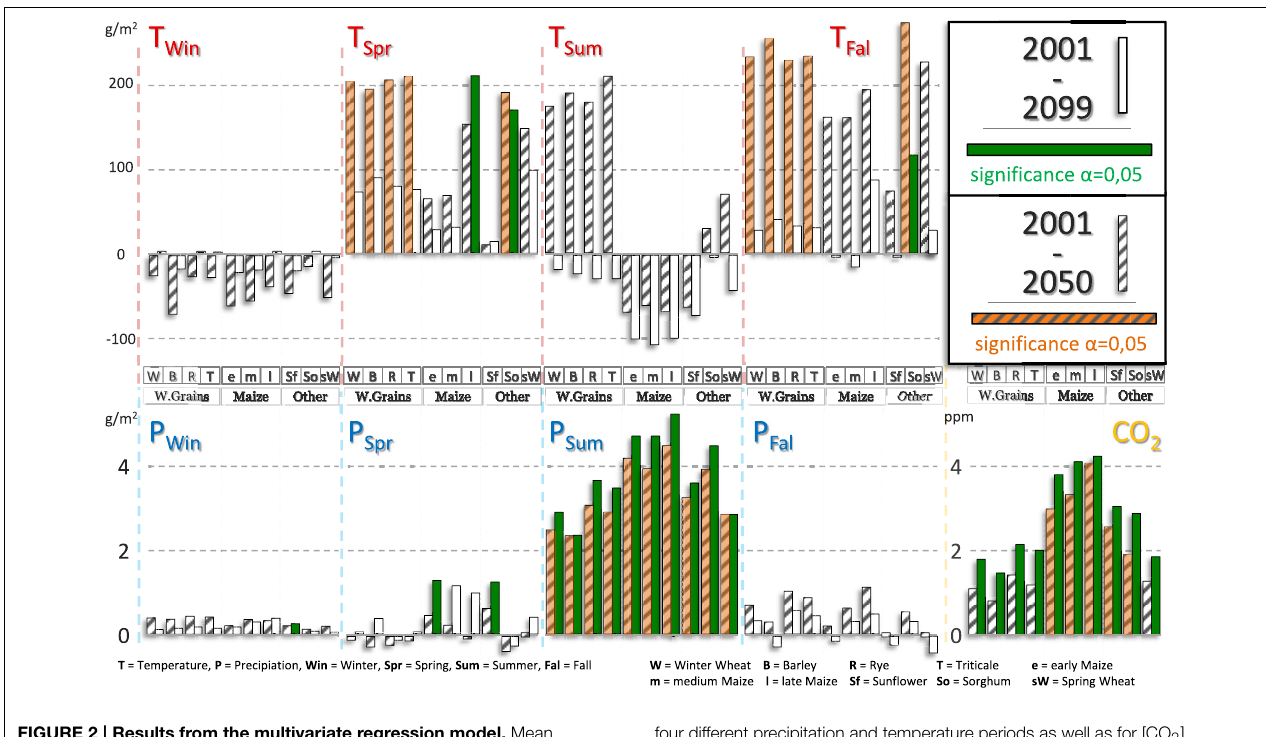
four different precipitation and temperature periods as well as for [CO 2 ]. Example: A green value of +2 of P sum means that if summer precipitation rises by 1mm, yields would rise by 2g/m 2 with α < 0 . 05 for the time